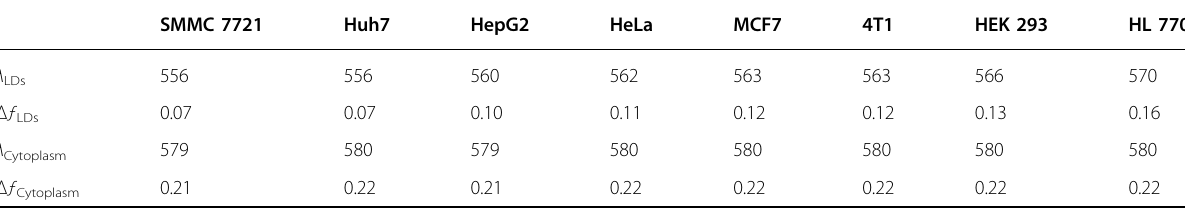
Table 1 The polarity of LDs and cytoplasm in different